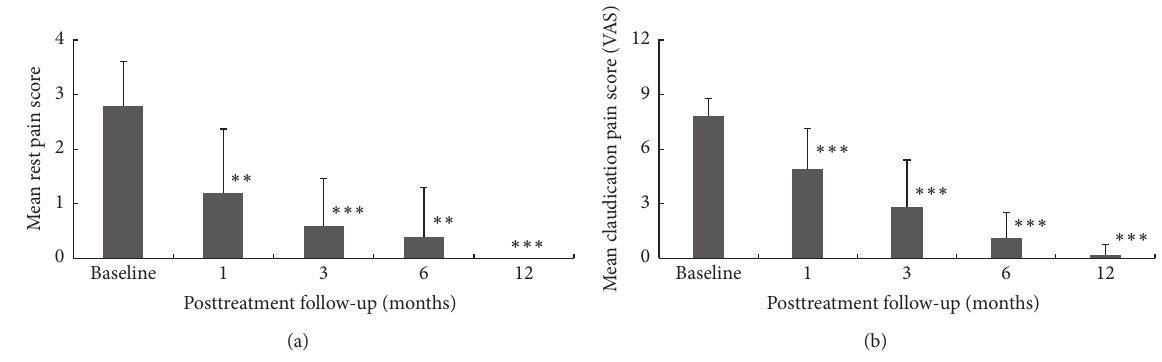
Figure6:(a)Analysisofrestpainandchangesfrombaselineto12months( ∗∗ 𝑝 < 0.01 ; ∗∗∗ 𝑝 < 0.001 ).(b)Analysisofintermittentclaudication